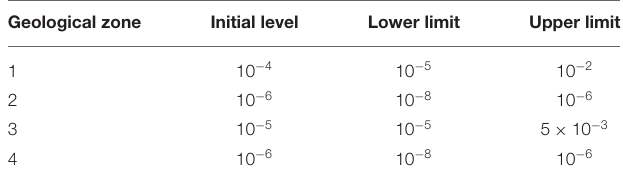
TABLE 1 | Hydraulic conductivity in m/s (initial and bounding values) of the parameter used under NSMC (for the geological zones description see Supplementary Figure 1